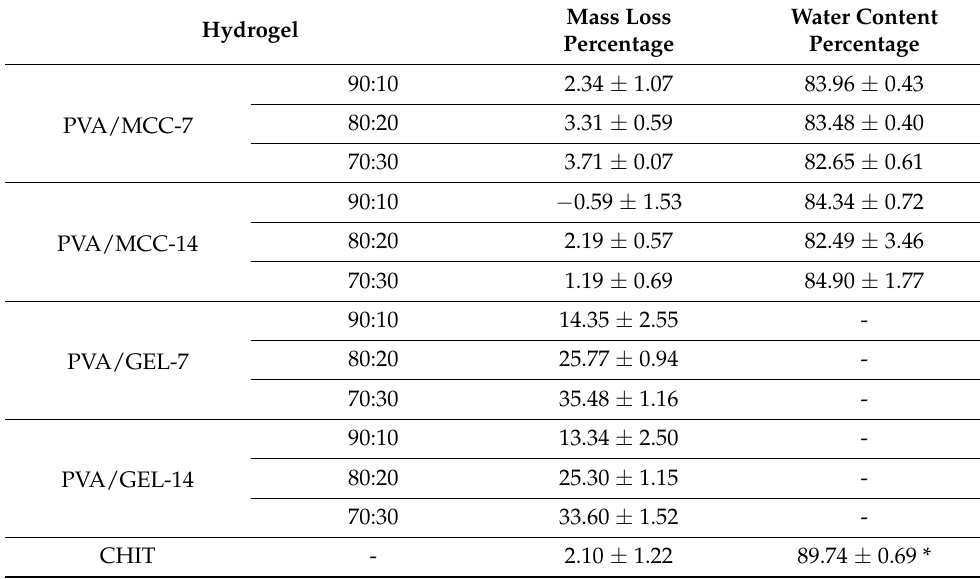
Table 3. Mass loss and water content percentage (mean ± SE; n = 3) of the hydrogels under study.